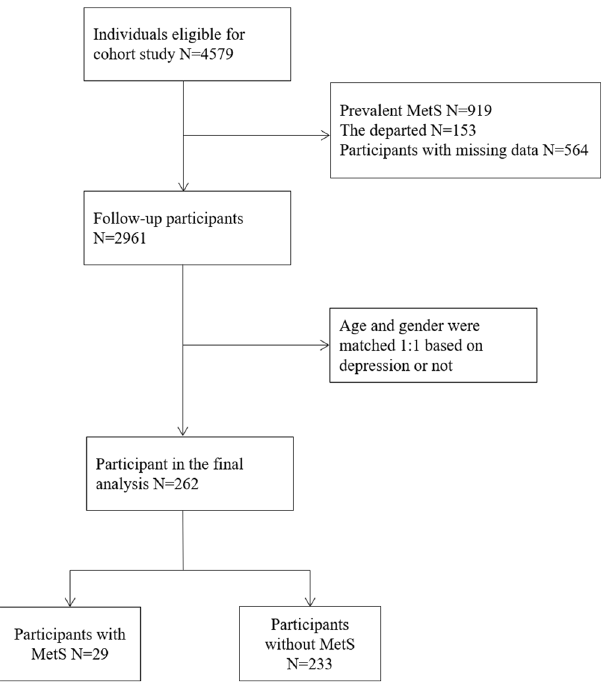
Figure 1. Flow diagram showing the screening of study participants. MetS metabolic